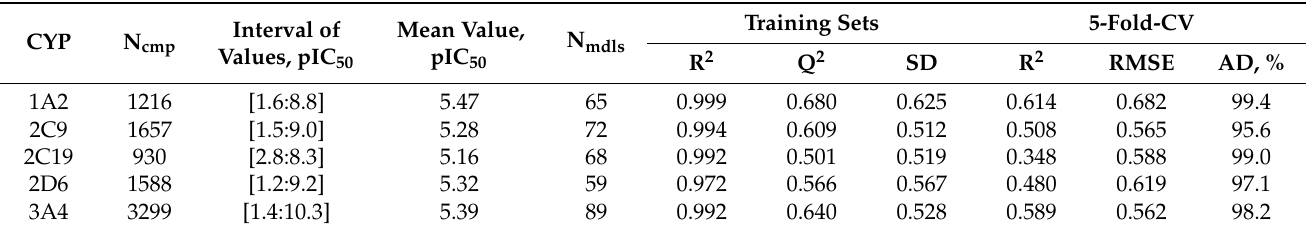
Table 1. Characteristics of the training sets and prediction accuracy of consensus QSAR models for CYP inhibitors.